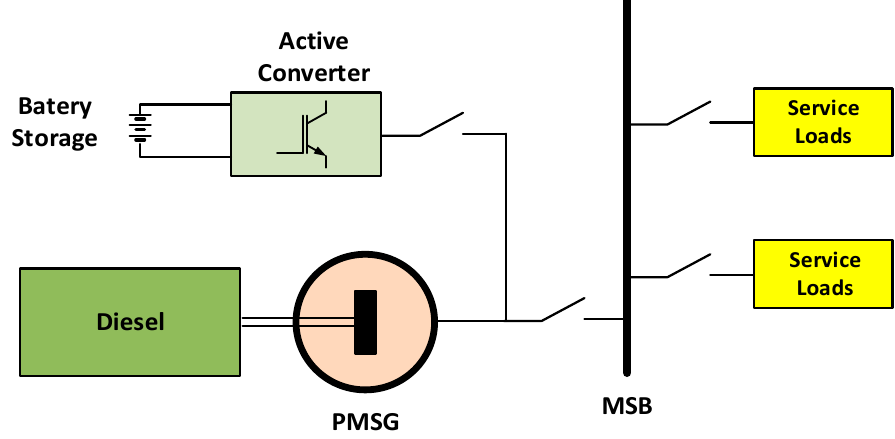
Figure 2. Autonomous hybrid power plant system with the PMSG in parallel topology.